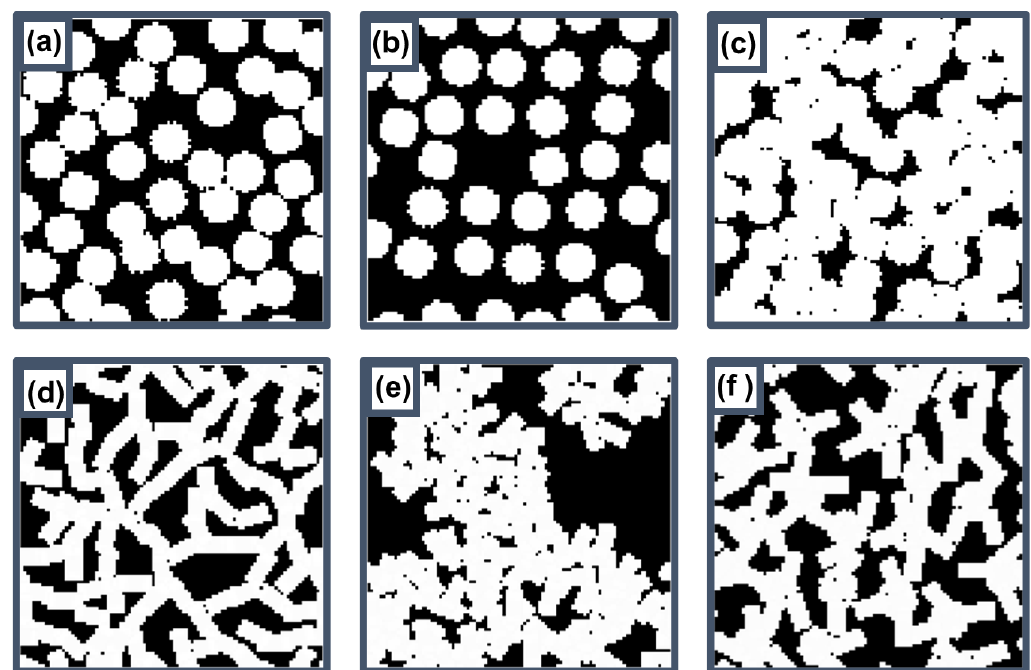
Figure 11. Various examples of digitally generated microstructures using only overlap and distance constraints: ( a ) non- overlapping circles, ( b ) non-overlapping circles with a prescribed minimum separation, ( c ) overlapping circles with 5% to 25% of their area, ( d ) wider angled overlap between tips of placed rectangles, ( e ) overlap between the centers of already placed rectangles and tips of rectangles to be placed, and ( f ) random non-overlapping circles modified by placing rectangles with tip regions that overlap the existing circles.